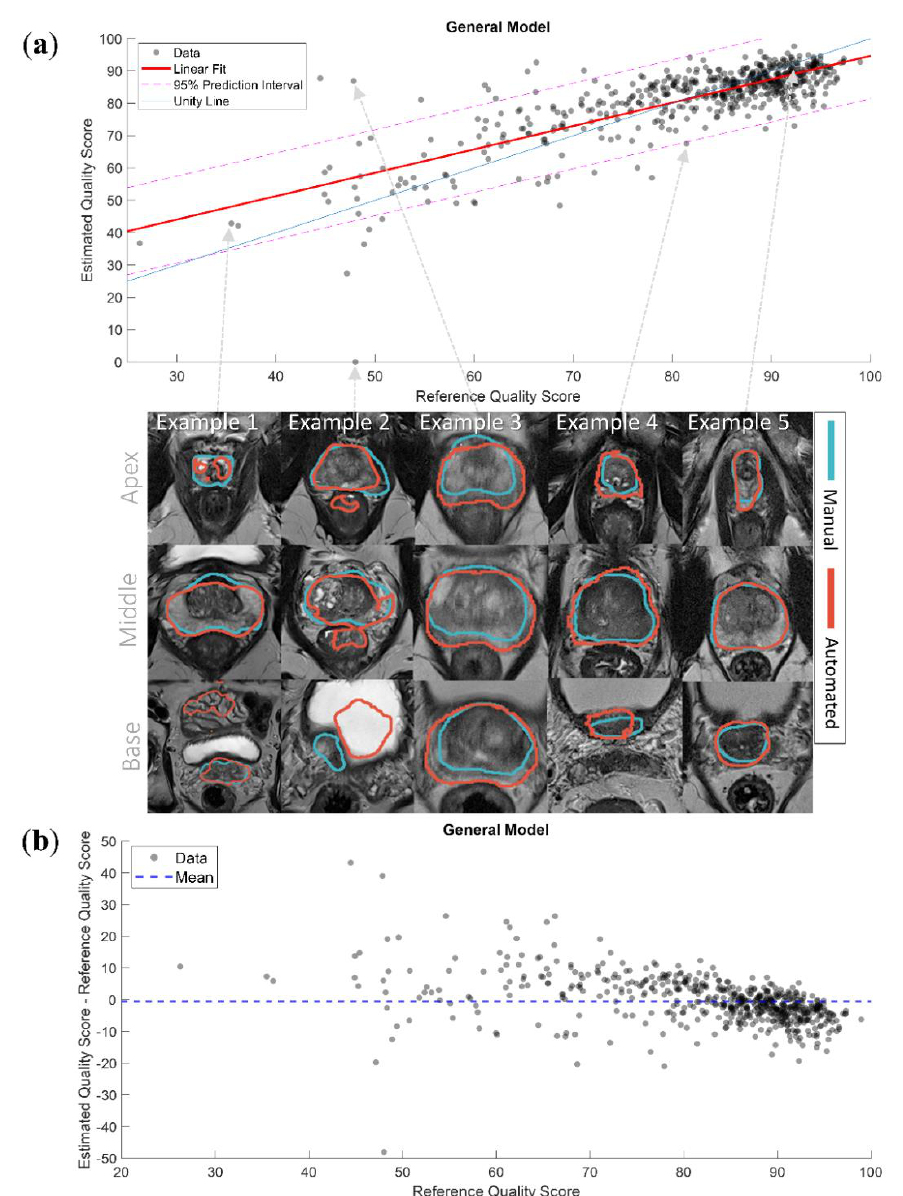
Figure 6. ( a ) The linear fit of the estimated quality scores with 95% prediction interval of the General model with examples of segmentations. Example 1 presents a case where the model accurately predicted the quality score (QS) of a low-quality automated segmentation; Example 2 presents a case where the model extremely underestimated the QS of a low-quality automated segmentation, the automated segmentation here covered parts of the rectum and the bladder; Example 3 presents a case where segmentation here misses the peripheral zone; Example 4 presents a case where the model slightly underestimated the QS of a high-quality automated segmentation, the automated segmentation here was slightly over segmented; Example 5 presents a case where the model accurately predicted the QS of